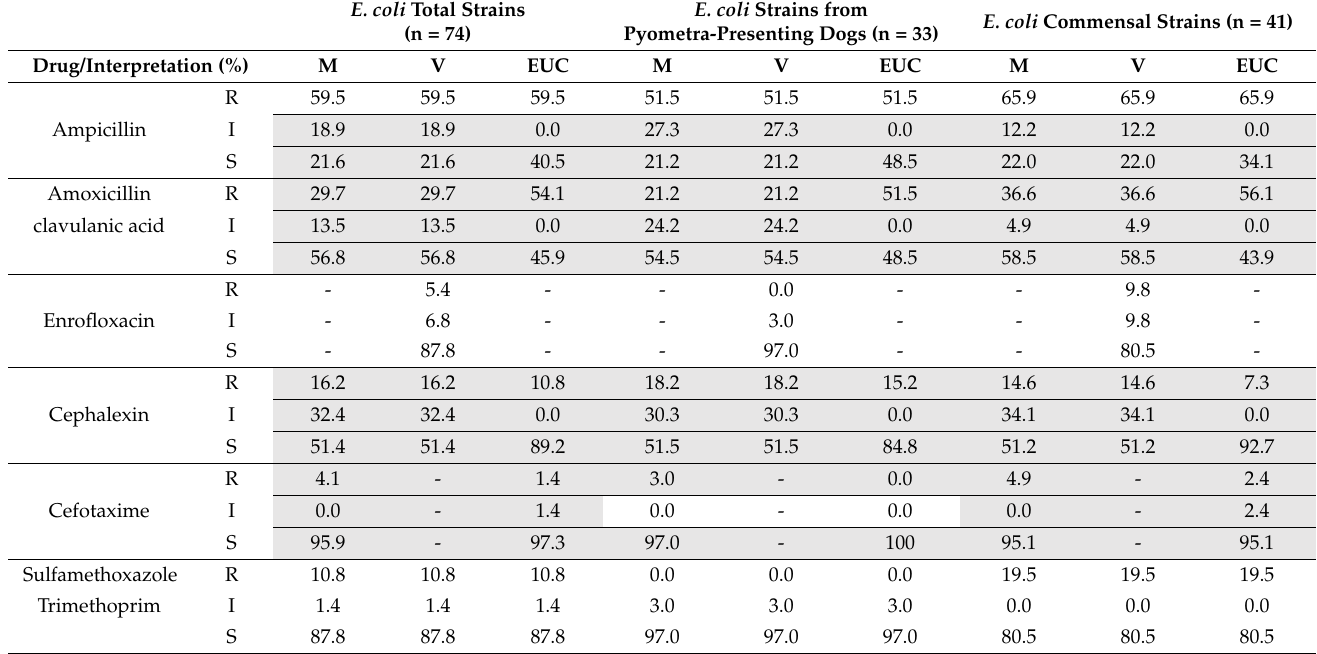
Table 2. Antimicrobial susceptibility testing results for ampicillin, amoxicillin/clavulanic acid, enrofloxacin, cephalexin, cefotaxime and sulfamethoxazole/trimethoprim. The frequency of resistant, intermediate and susceptible strains according to the different AST guidelines, namely CLSI M100, CLSI VET01S and EUCAST, is represented. The differences in AST evaluation results are highlighted. E. coli Total Strains (n =